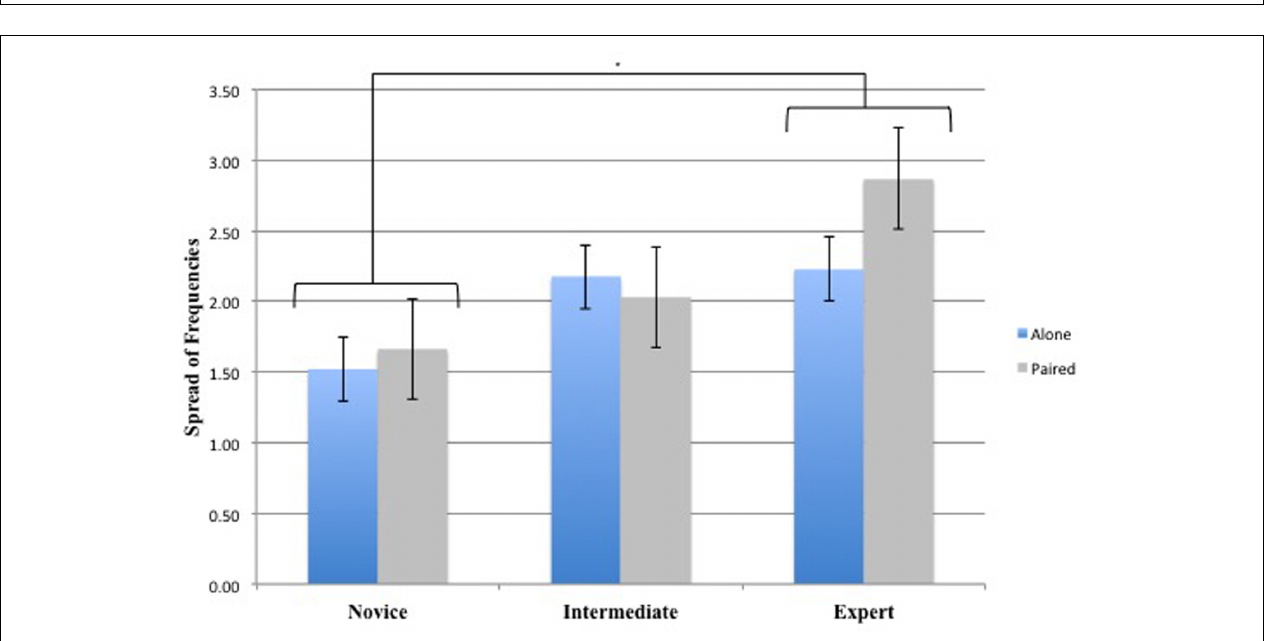
FIGURE 3 | Spread of Frequencies for the 3 Groups (Novice, Intermediate, and Expert) and the 2 Conditions (Alone and Paired). ∗ Asterisks indicate significant differences P < 0.05.